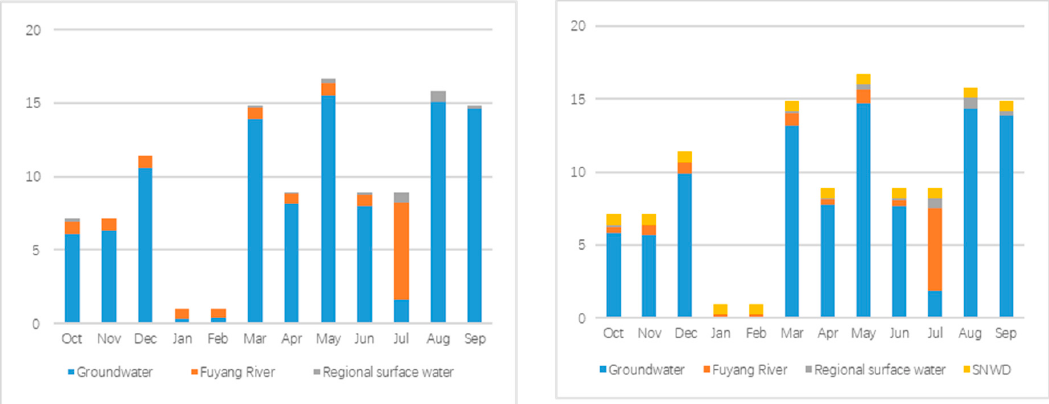
Figure 3. Monthly water use in a normal year of Cheng’an (Unit 10 6 m 3 ).